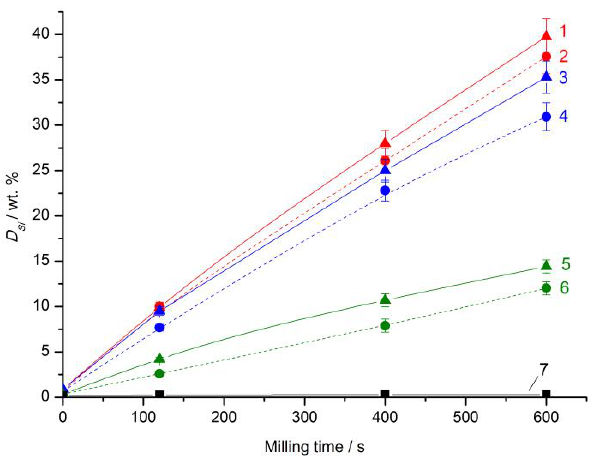
Figure 8. Leaching of silicon ( D Si ) from antigorite milled in moderate conditions in air (1, 2) and in CO 2 (3, 4) and from AT milled in air (5, 6) as a function of milling time. For curves 1 – 6 , solid and dashed lines designate leaching with 5 M and 2 M NaOH, respectively. For comparison, curve 7 represents leaching of silicon from antigorite milled in moderate conditions in air with water.